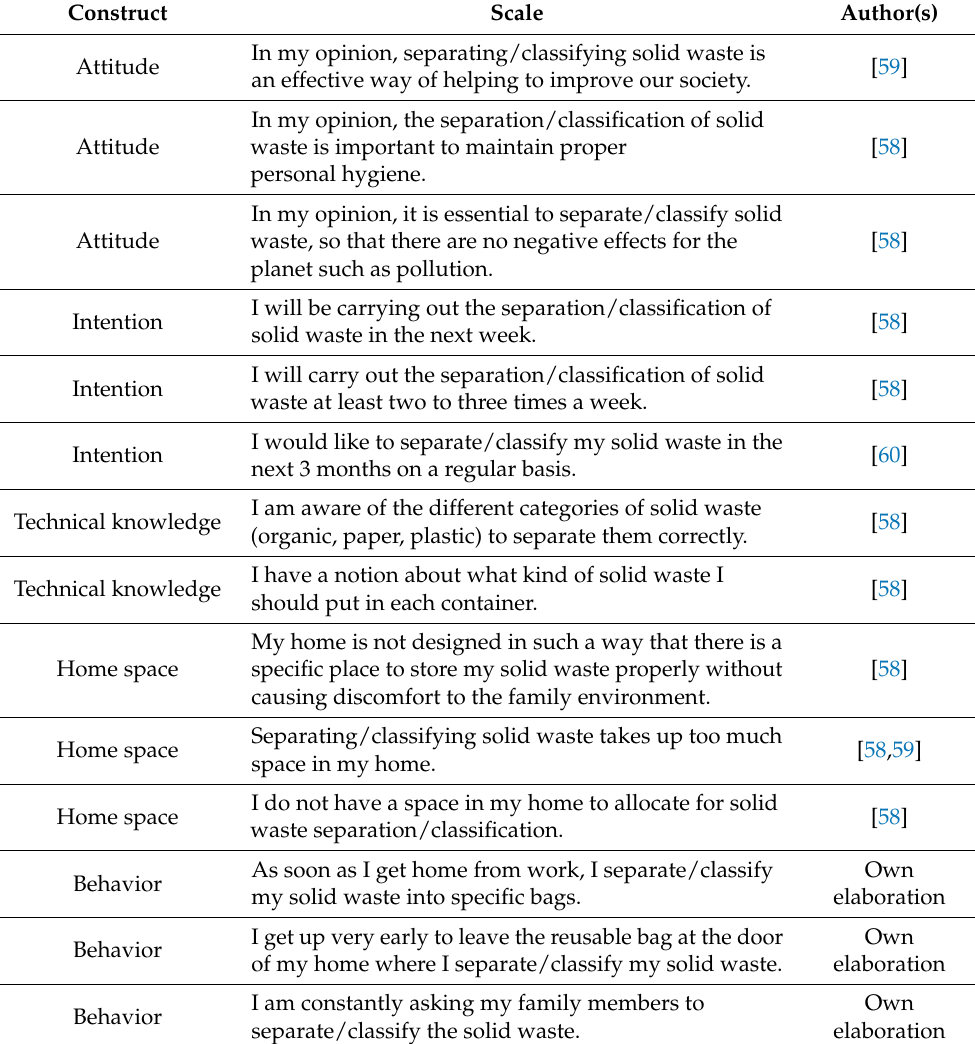
Table 2. Constructs considered in this study, referring to previous